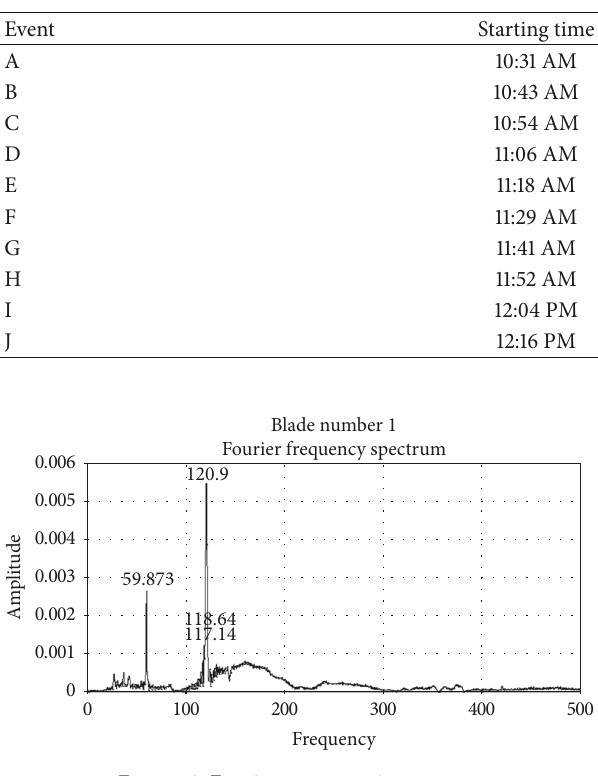
Table 1: Starting times for ten data recording events with airflow.